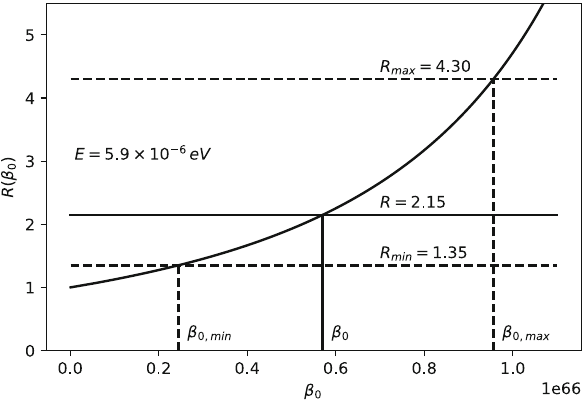
Fig. 3 R vs β 0 for fixed energy E = E 12 (cid:2) 5 . 9 × 10 − 6 eV